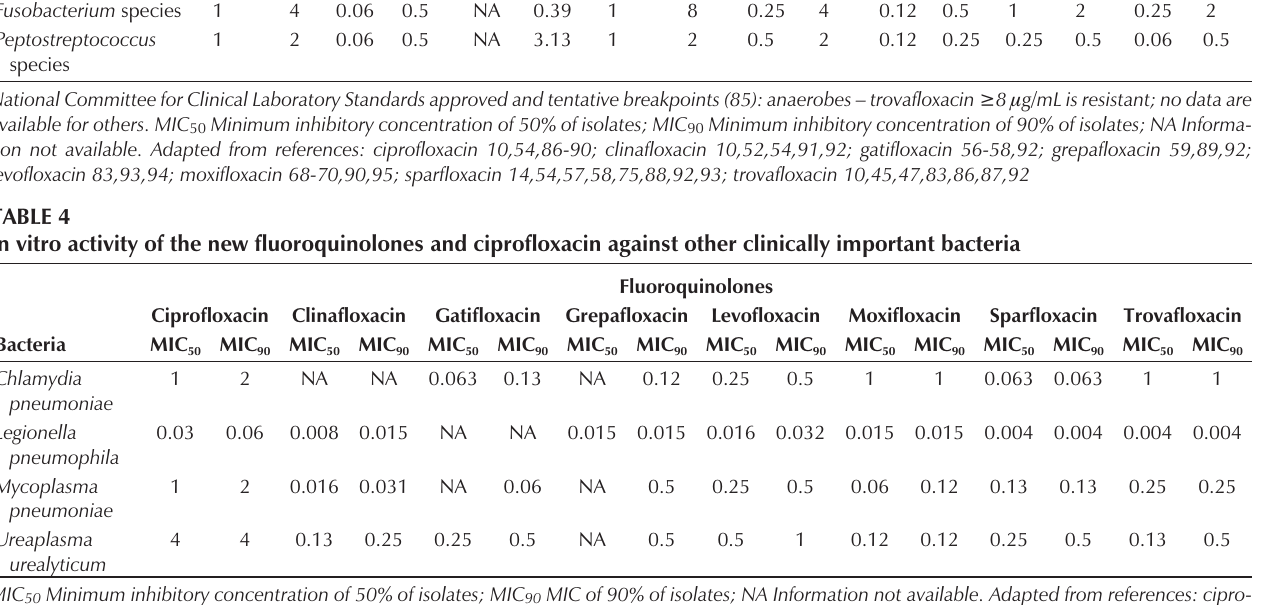
Clostridium perfringens